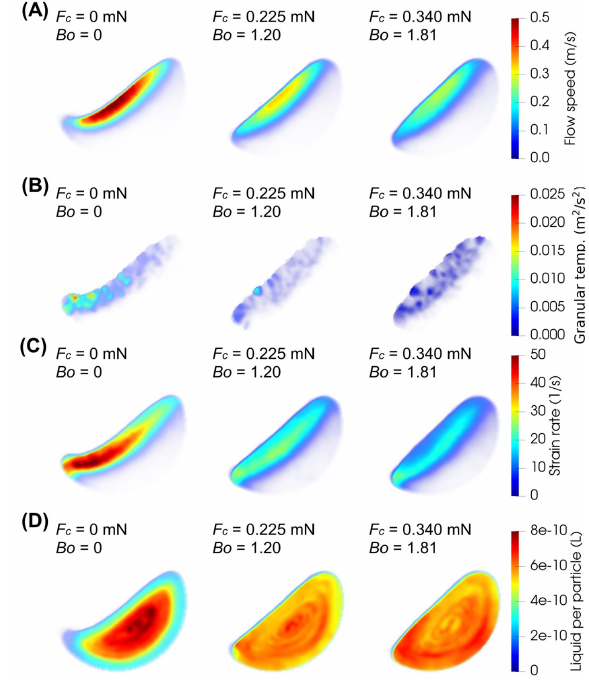
Figure 7. (A) flow speed, (B) granular temperature, (C) strain rate, and (D) liquid distribution, obtained using DEM simulations for various capillary forces and for Fr = 0 .